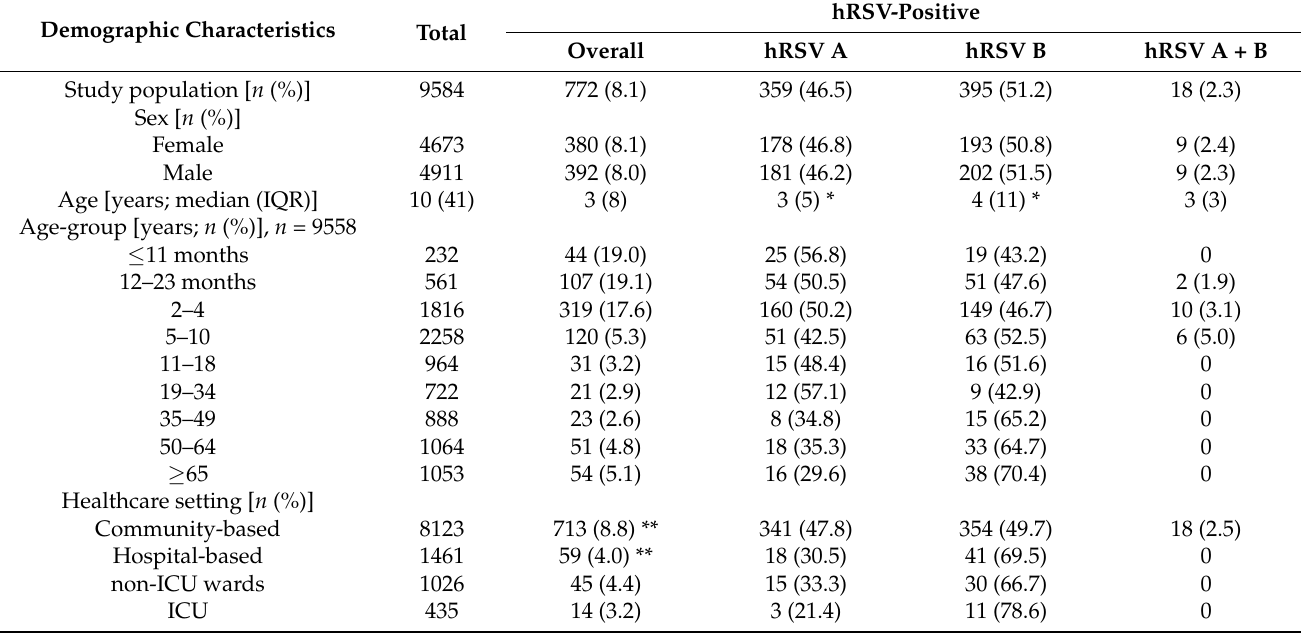
Table 1. Demographic characteristics of the study population according to hRSV detection. Period: 2015–2020. Demographic